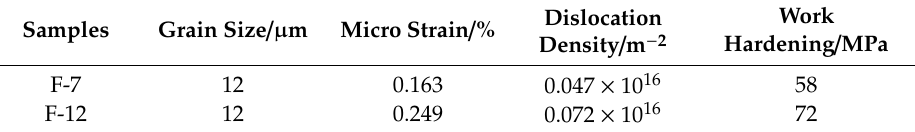
Figure 8. Fracture surfaces different samples: ( a ) AE; ( b ) F-7; ( c ) F-12.